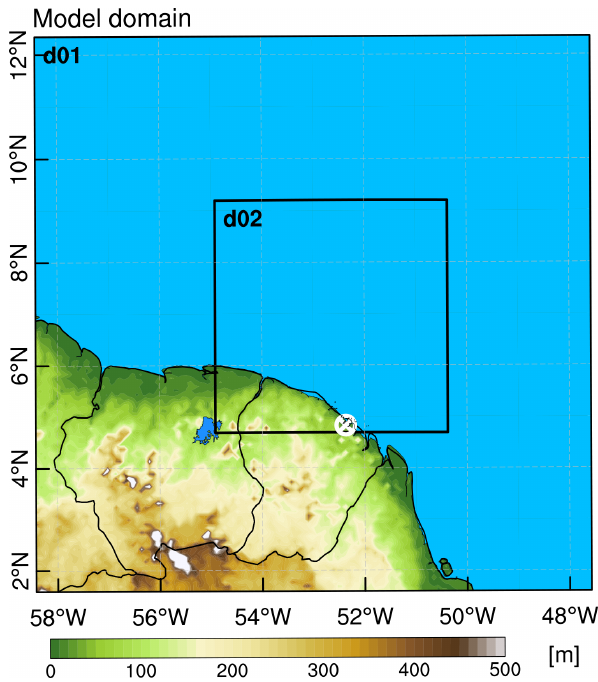
Figure 2. The model domain configuration (color shaded fields rep- resent terrain elevation, in m). The horizontal grid spacings of d01 and d02 are 3 and 1km, respectively. The white mark “ ⊗ ” repre- sents the location of the release of a radiosonde at